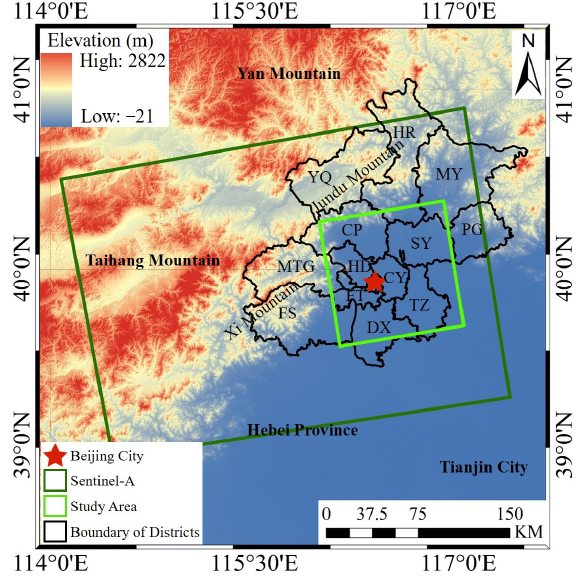
Figure 1. The digital elevation model (DEM) map of Beijing, China. The black curve shows the administrative division of Beijing. The dark green box is the extent of the SAR imagery, and the light green box is the main study area, which covers most of the Beijing plain. The red star represents that it is China’s capital.